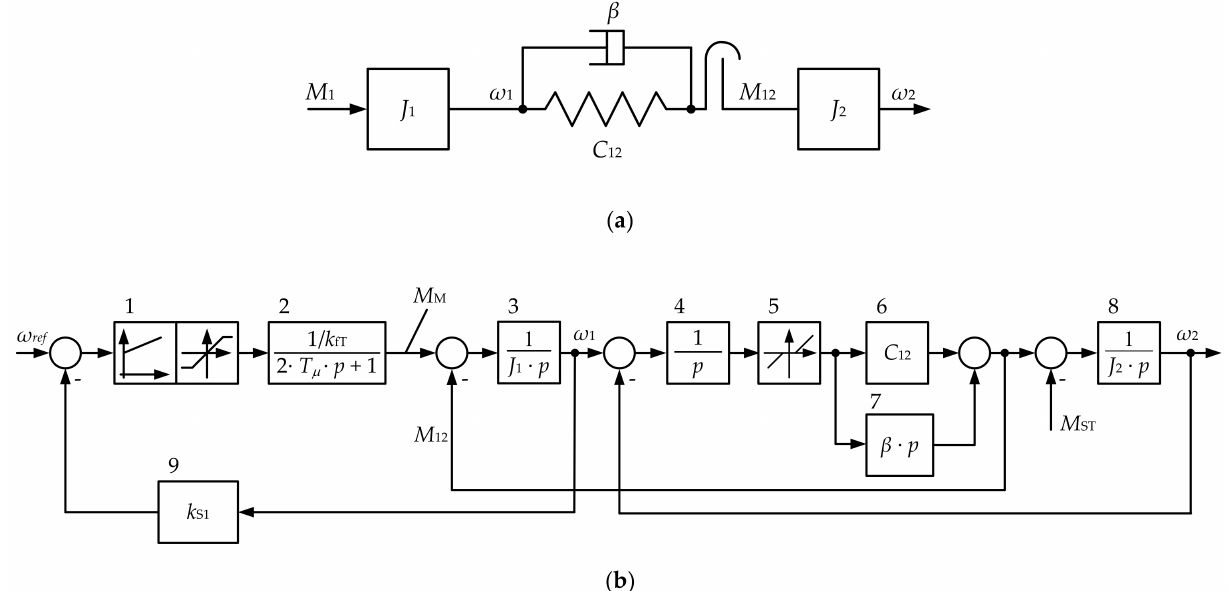
Figure 5. Kinematic diagram of the transmission ( a ) and block diagram of the two-mass electromechanical system ( b ): T µ for the uncompensated time constant; J 1 , J 2 for the moments of inertia, first mass and second mass; C 12 for the elastic coefficient of the mechanical transmission; β is the natural damping ratio (viscous friction type); M M is the motor torque; M 12 is the elastic torque of the spindle; M ST for the load torque; ω ref for the configured angular speed of the motor; ω 1 , ω 2 for the speeds of the first mass (the motor) and the second mass (the roll), respectively; k S1 for the first mass speed feedback gain; k fT for the motor torque feedback gain in the